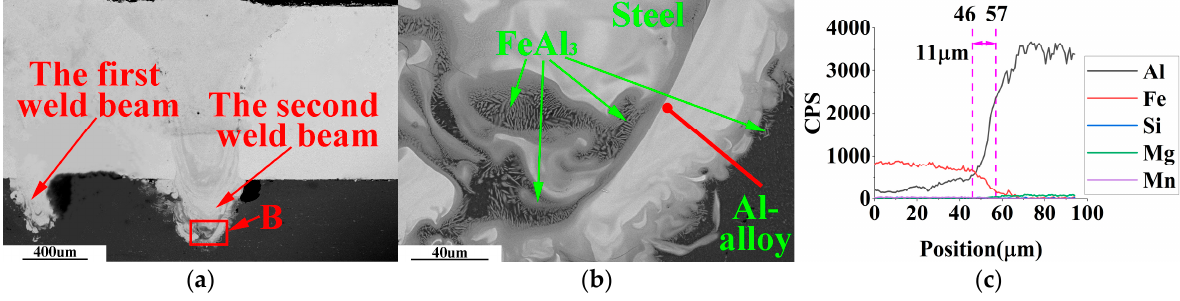
Figure 10. SEM-EDS observation of weldment with weld spacing of 1.0 mm. ( a ) Main areas of weld cross-section; ( b ) enlarged view of area B in Figure 10a; ( c ) EDS line scan results of the red line in Figure 10b.